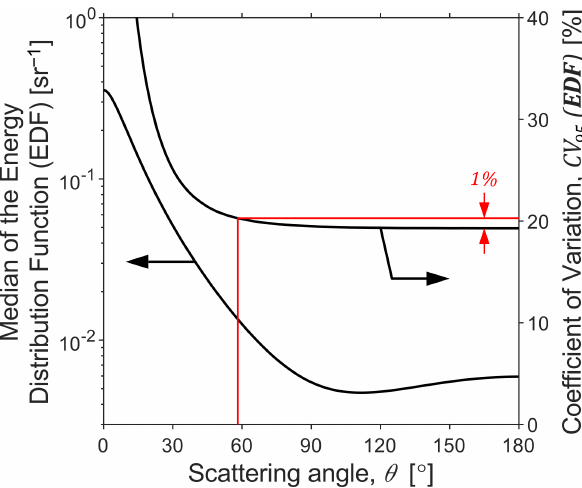
Figure 4. Central tendency (median; left logarithmic axis) and rela- tive uncertainty (CV 95 ; right linear axis) of the “energy distribution function” (EDF = ω ( b ) p ( θ, b ) / 4 π) that dictates the fraction of in- cident light energy scattered through angle θ by soot. The magni- tude and uncertainty in the EDF are much larger in the forward scat- tering direction (small θ ). As the scattering direction exceeds ∼ 90 ◦ however, the relative uncertainty in the EDF approaches a constant minimum, implying that the relative uncertainty in S 1,sun is mini- mized for θ s ˜ > 90 ◦ . The red line shows that relative uncertainty is within 1% of the minimum if θ s ˜ > 60 ◦